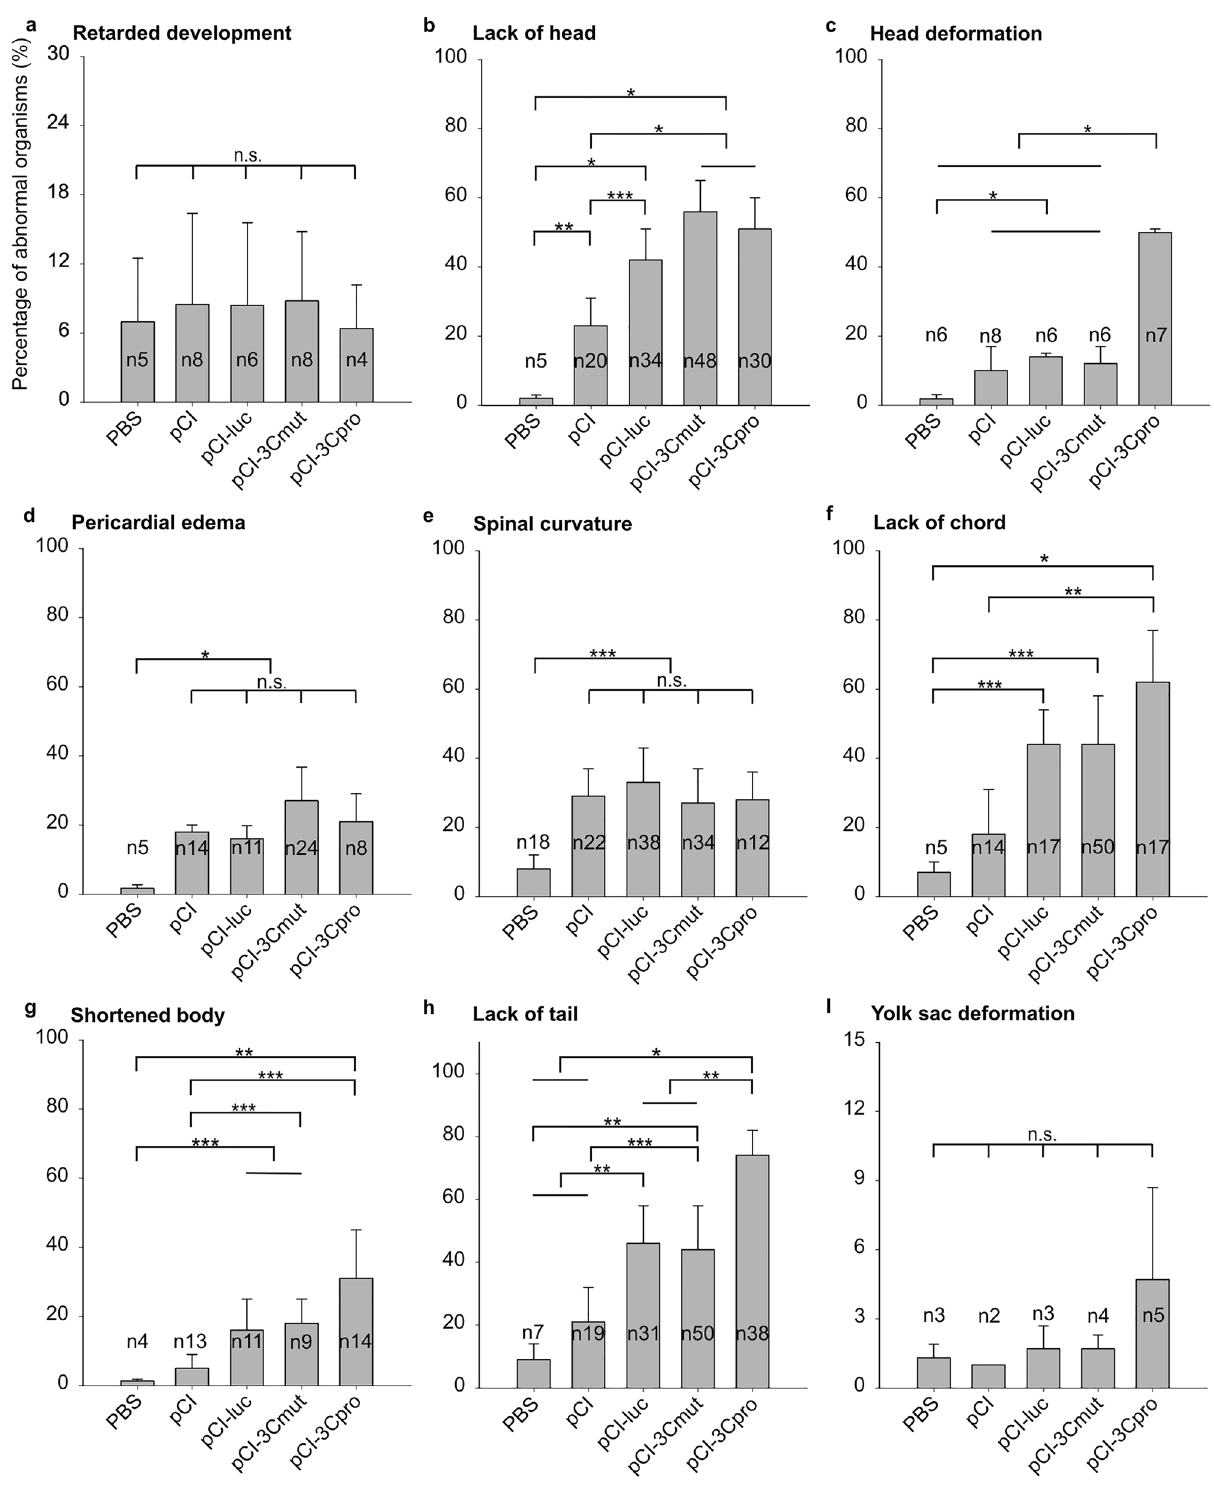
Figure 5. Main abnormalities revealed in developing Danio rerio embryos. Data are given for embryo injected with PBS or 33 attomoles of pCI, pCI-luc, pCI-3Cmut, and pCI-3Cpro. The incidence of each developmental abnormality (ordinate) was calculated relative to the total number of abnormal embryos observed 24 h after injection minus the proportion of control (uninjected) embryos with the same abnormality. Values are represented as mean of six independent experiments. Error bars indicate standard deviation (SD). The number of embryos analyzed (n) is specified in the figure, *p < 0.001; **p < 0.01; ***p < 0.05; n.s. not significant for all columns in the specified